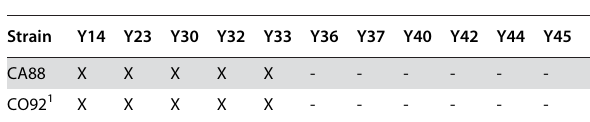
Table 5. Presence/absence of IS 100 loci described in Achtman